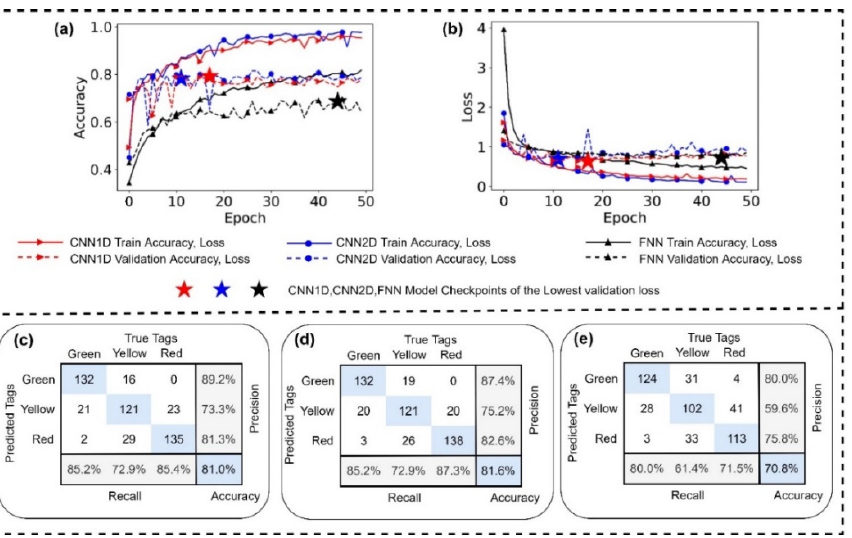
Figure 6. The training, validation, and test results of the three neural network models: ( a ) the accuracy histories on the training and validation sets; ( b ) the loss histories on the training and validation sets; ( c ) the test confusion matrix on the test set of 1D CNN model; ( d ) the test confusion matrix on the test set of 2D CNN model; and ( e ) the test confusion matrix on the test set of FNN